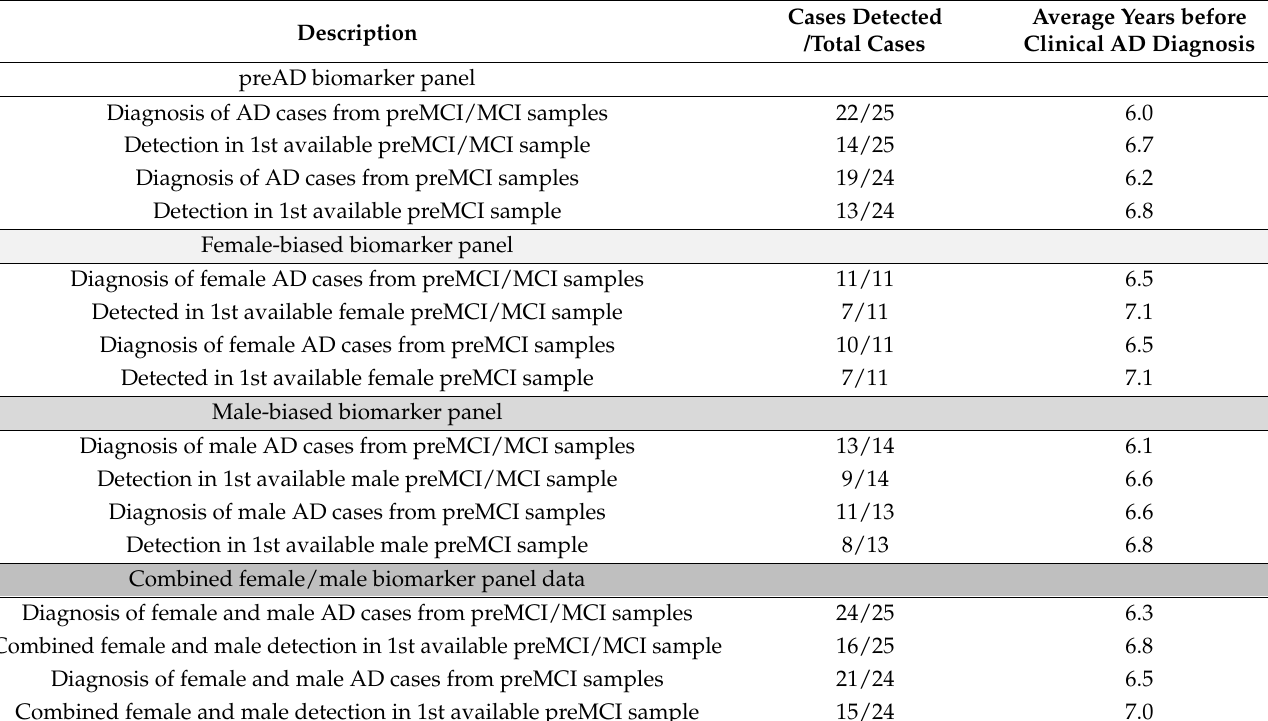
Table 4. Early detection of